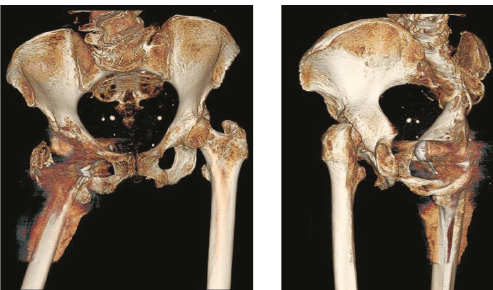
Figure 4: Three-dimensional reformatted computed tomography (CT) images showing femoral component dislocation through the right obturator